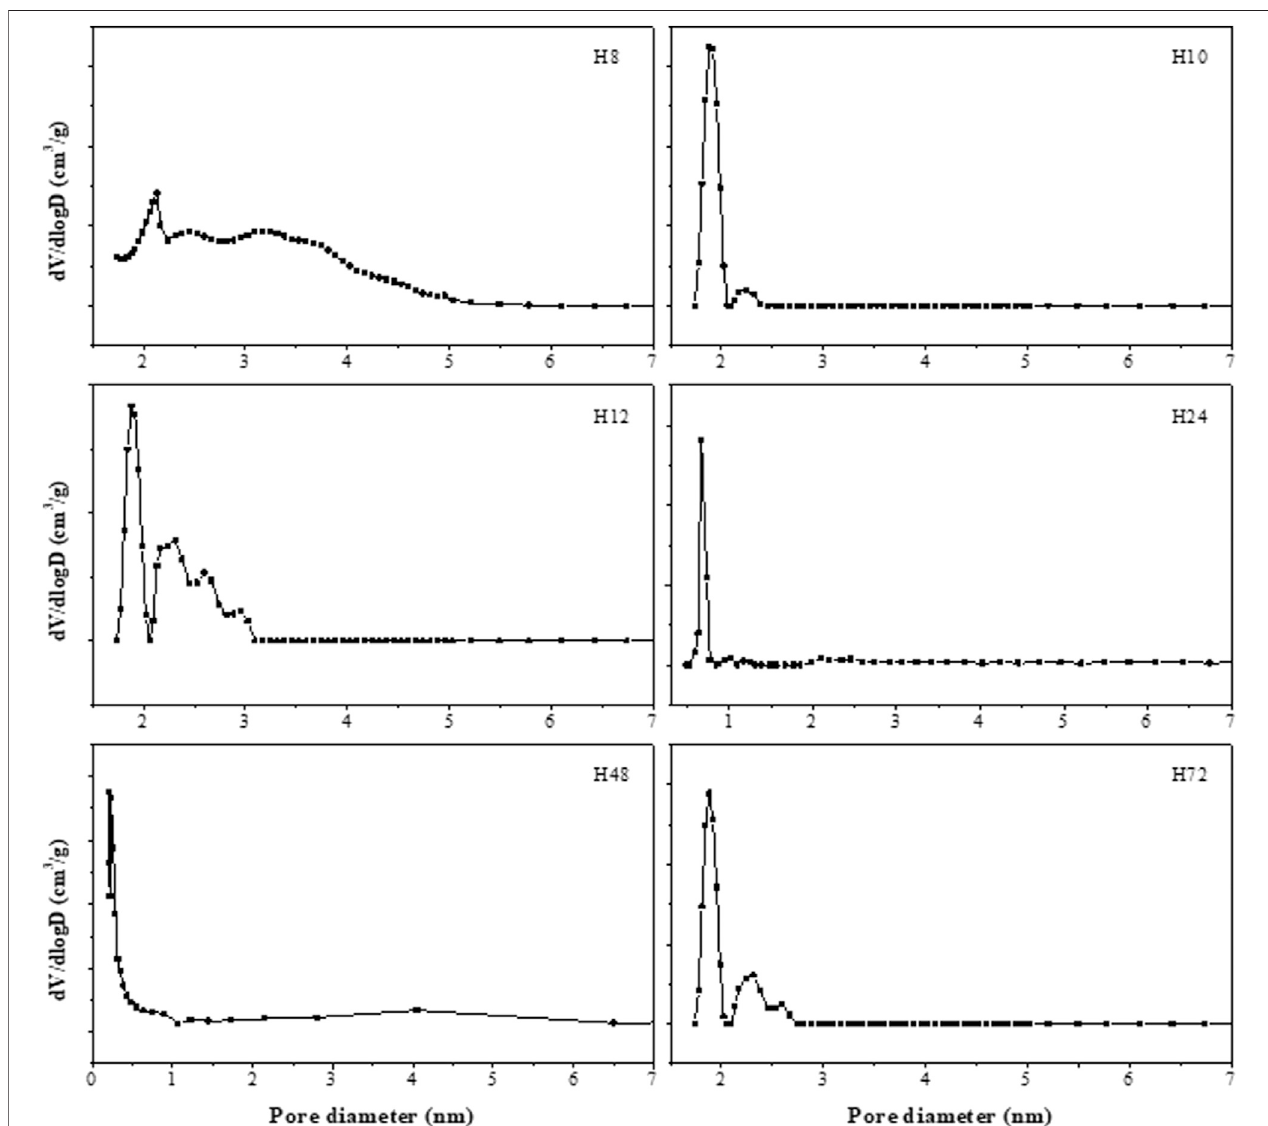
FIGURE 9 | Mesopore size distributions of as-synthesized HBEA zeolites produced from CFA nanosilica extract at different hydrothermal times.